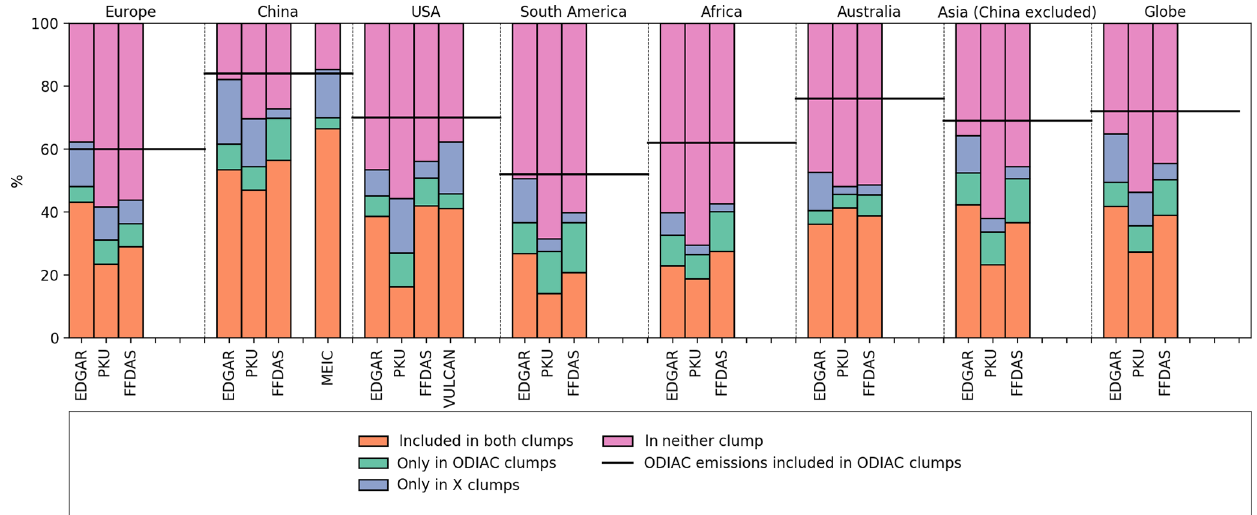
Figure 8. The fractions of emissions from corresponding emission products covered (1) by both ODIAC clumps and X clumps (red), (2) only by X clumps but not by ODIAC clumps (green), (3) by ODIAC clumps but not by X clumps (blue), and (4) by neither ODIAC clumps nor X clumps (pink). The thick black lines indicate the fractions of emissions in ODIAC covered by ODIAC clumps.